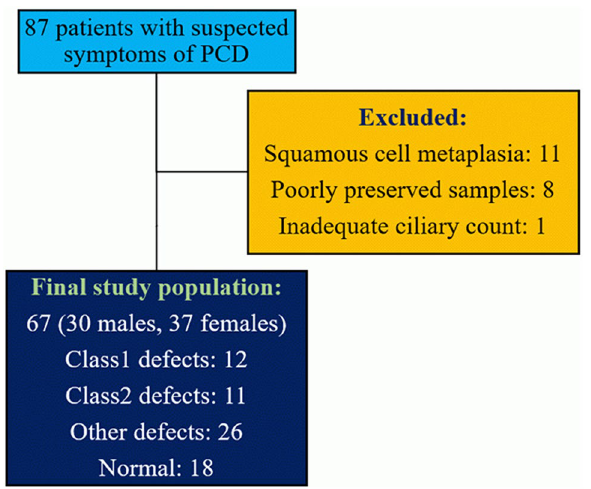
Figure 3. Inclusion and exclusion